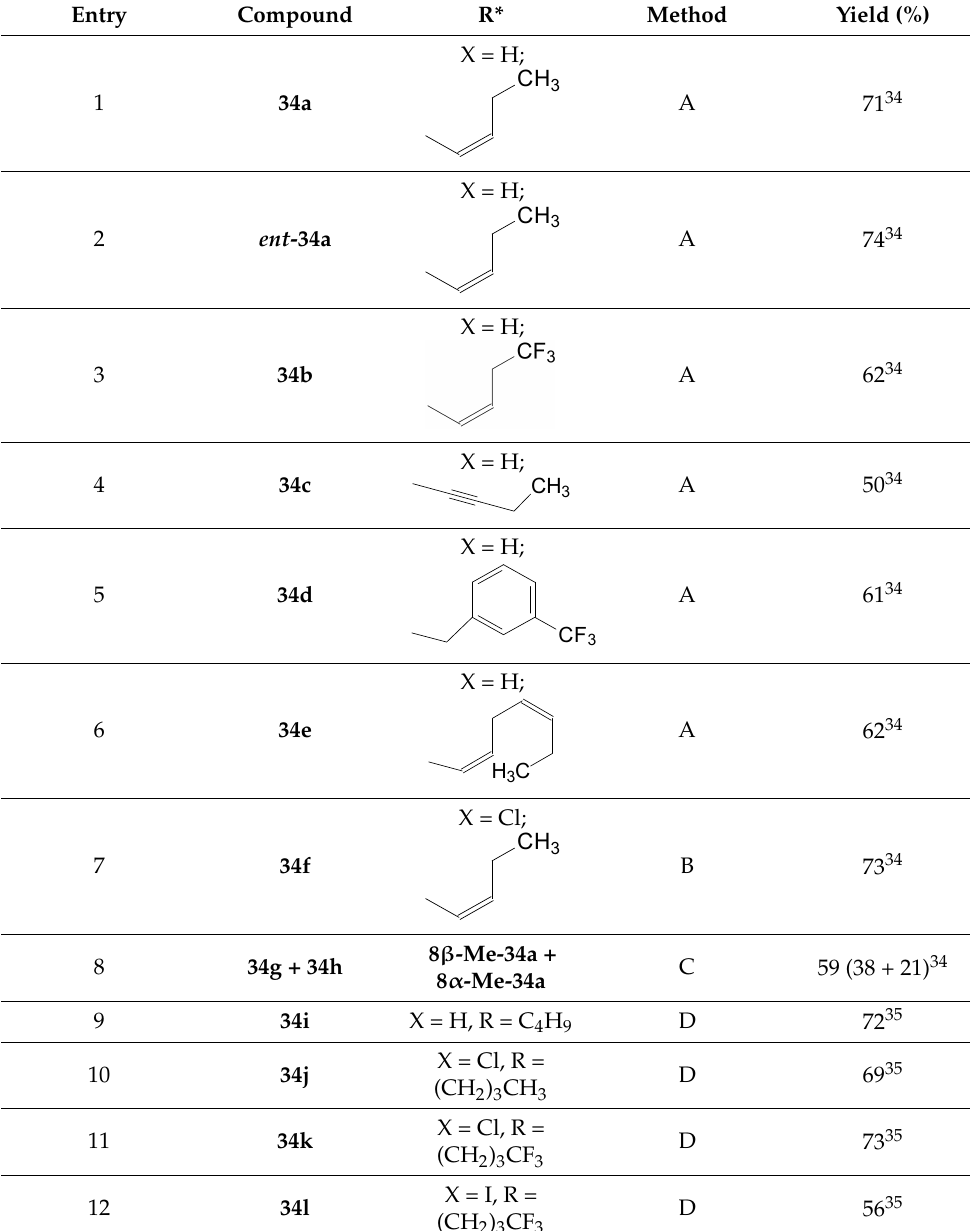
Table 2. ∆ 12 -PGJ 2 -, PGJ 3 -1,15-lactones and their analogs: method of synthesis and yield.